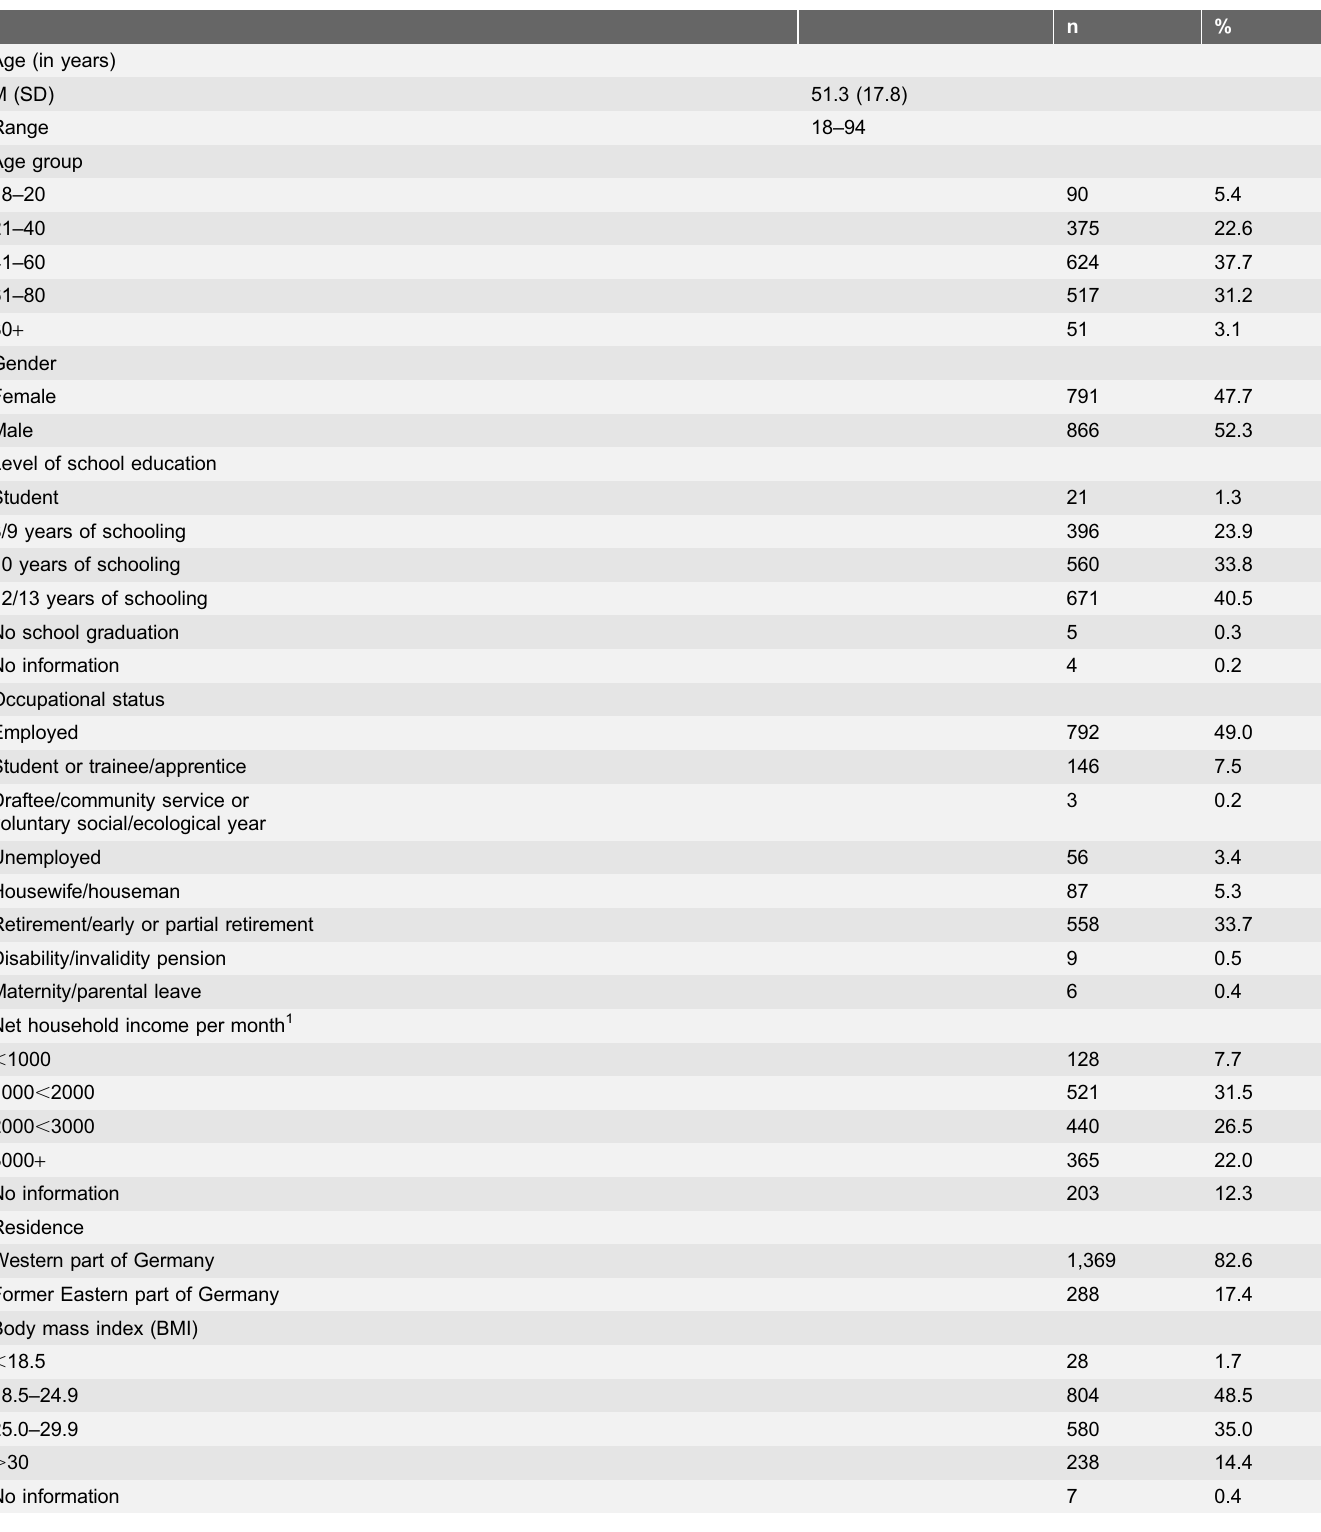
Table 1. Socio-demographic characteristics of the study sample (n 5